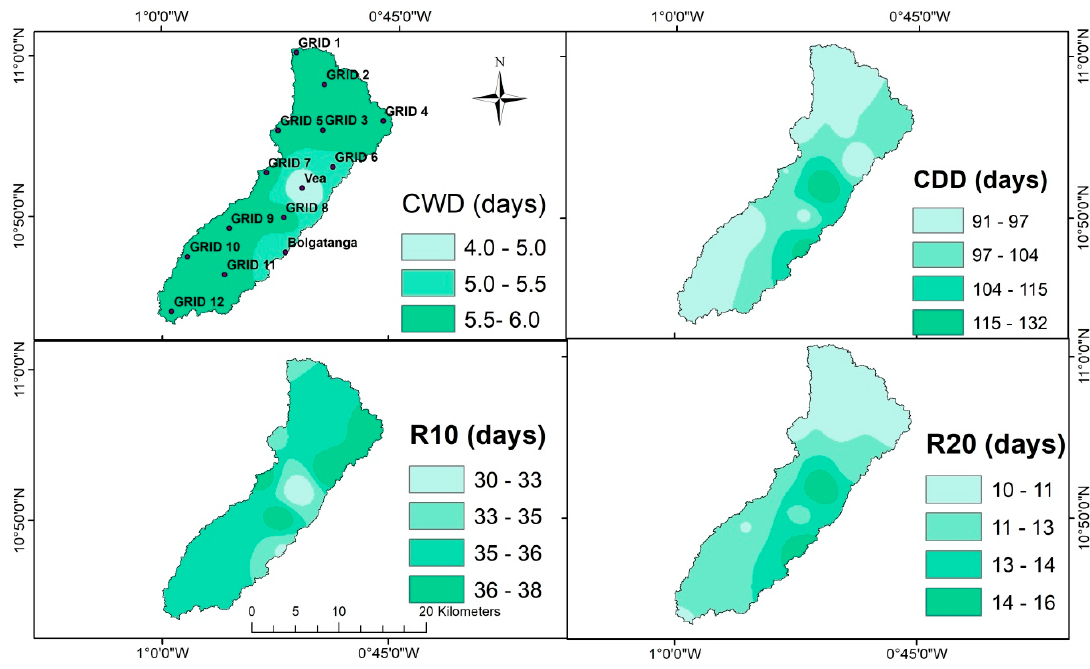
Figure 5. Spatial distribution of frequency of extreme rainfall Indices.